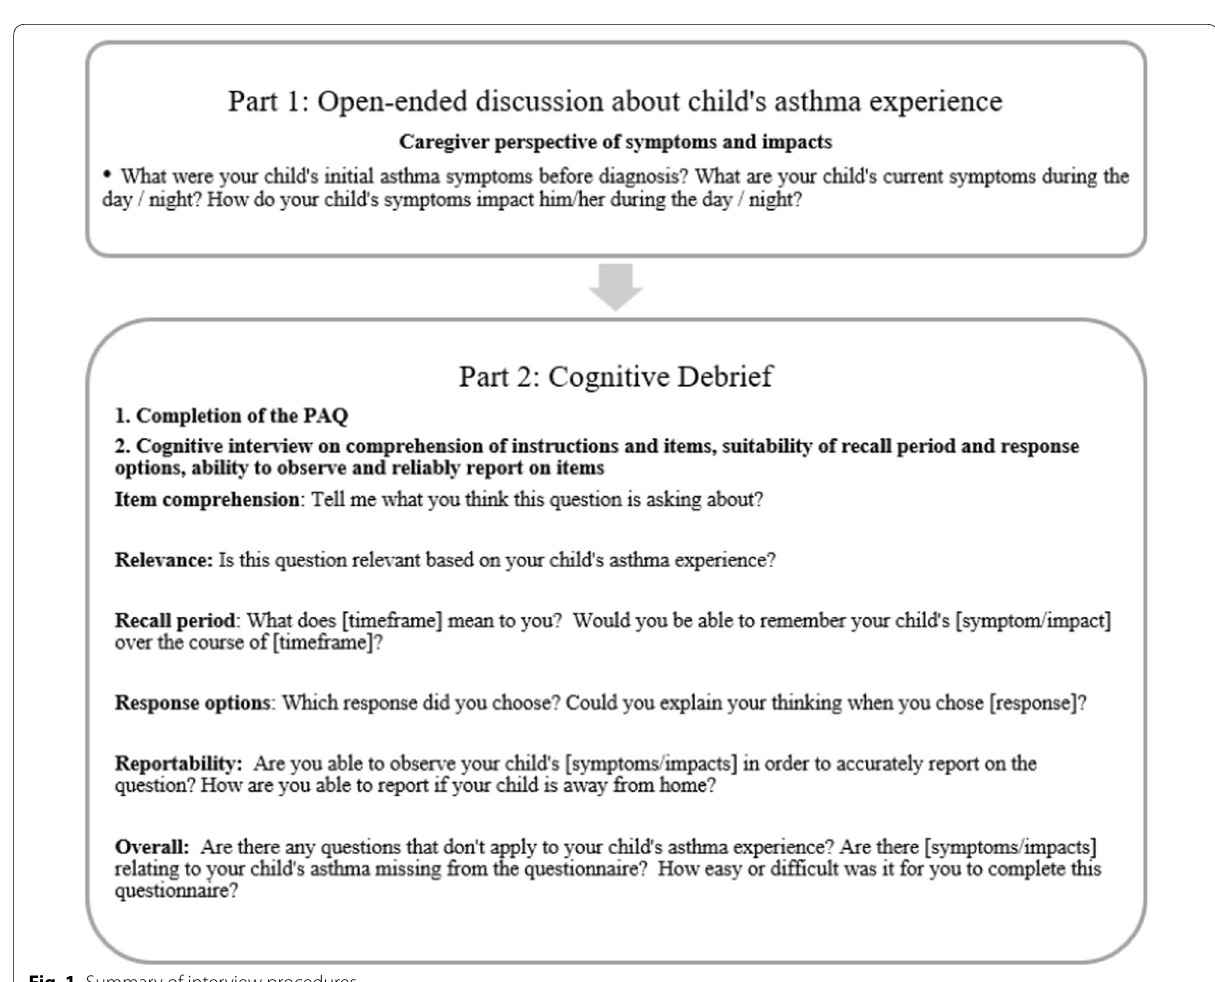
Fig. 1 Summary of interview